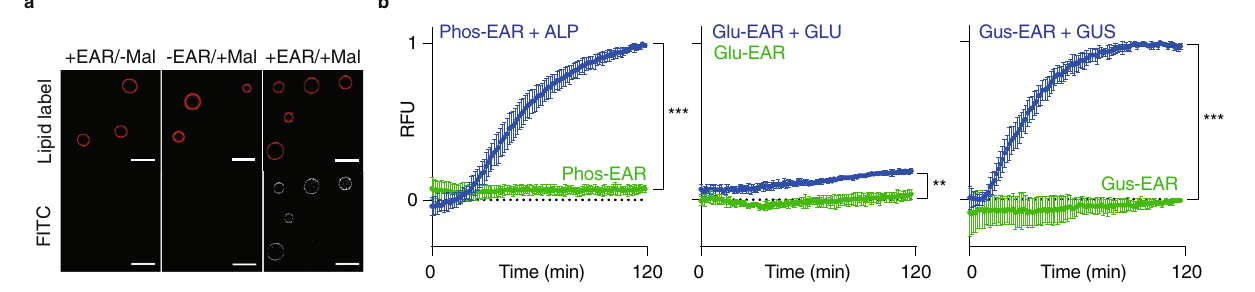
Fig. 4 | Lipid bilayer anchoring and proof of concept signaling. a Confocal fl uorescence microscopy imaging illustrating association of the GUS-speci fi c receptor molecule with the lipid bilayer of the GUVs; EAR=enzyme-activating receptor, Mal= fl uorescein maleimide, scale bars are 20 µ m. b Kinetic data illustrating evolution of fl uorescence in suspensions of liposomes that contain a disul fi de-based zymogen of papain and its speci fi c fl uorogenic substrate (Arg-AMC); liposomes were equipped with 2 μ M Phos-EAR, 20 μ M Glu-EAR, or 20 μ MGus-EARandthenexposedtothecorrespondingactivatingenzyme,alkaline